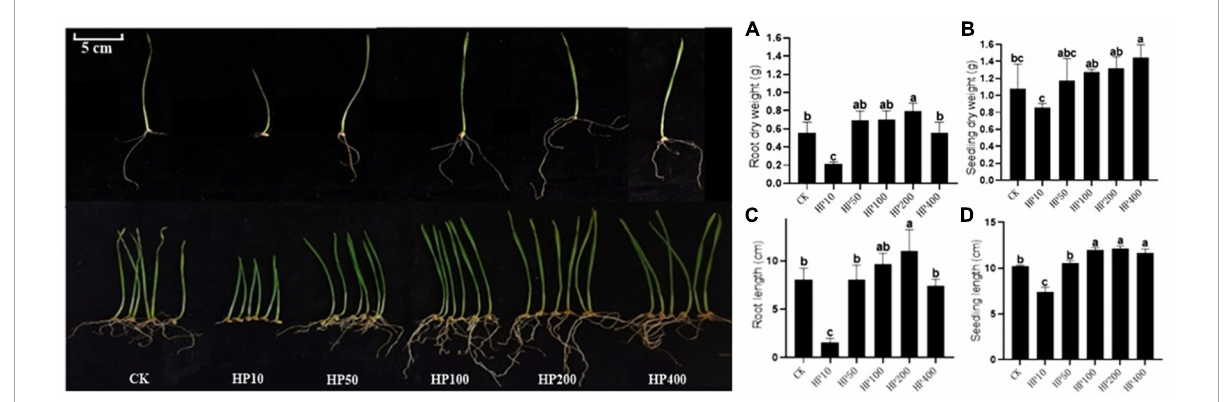
FIGURE5 Effect of different dilutions of Streptomyces co-culture in BF4 medium fermentation broth on wheat growth promotion for 8 days [ (A) , root dry weight; (B) , seedling dry weight; (C) , root length; (D) , seedling length; CK, treatment with water; HP10 ∼ 400, treatment with 10 ∼ 400 times fermentation broth dilution].